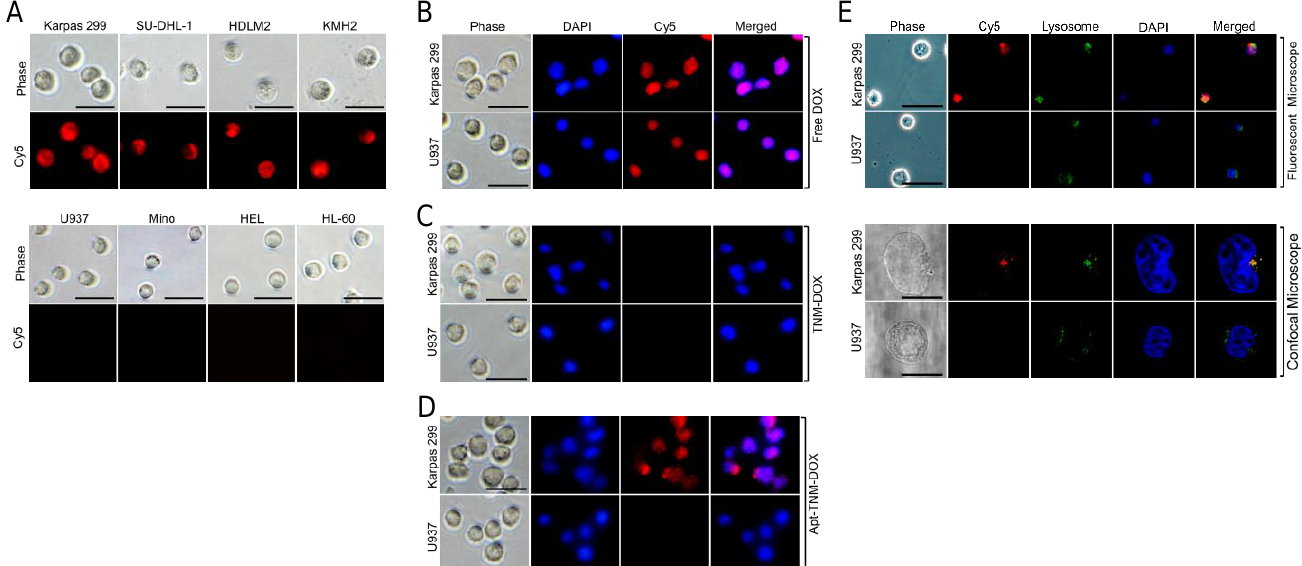
Figure 6. Cell-specific delivery and intracellular release of drug payload by Apt-TNM-DOX. ( A ) Cy5-labeled Apt – TNM-DOX specifically bound to CD30 + lymphoma cells (Karpas 299, SU-DHL-1, HDLM2, and KMH2), but did not react to off-target CD30 − control cells (U937, Mino, HEL, and HL-60). ( B ) DOX drug freely penetrated tumor cells without specificity detected by DOX fluorescent signals. ( C ) TNM-DOX did not show cell uptake. ( D ) Intracellular delivery and release of DOX payload by non-labeled Apt – TNM-DOX occurred in Karpas 299 lymphoma cells but not in off-target U937 control cells. ( E ) Colocalization of Cy5-labeled Apt – TNM-DOX and cellular lysosomes stained by FITC-lysosome tracker was confirmed in Karpas 299 cells but not in off-target U937 cells by fluorescent microscopy (upper panels) and confocal microscopy (lower panels). Cell nuclei were stained with DAPI fluorescent dye in B-E. Scale bars are 10 µm in E, and 25 µm in others.